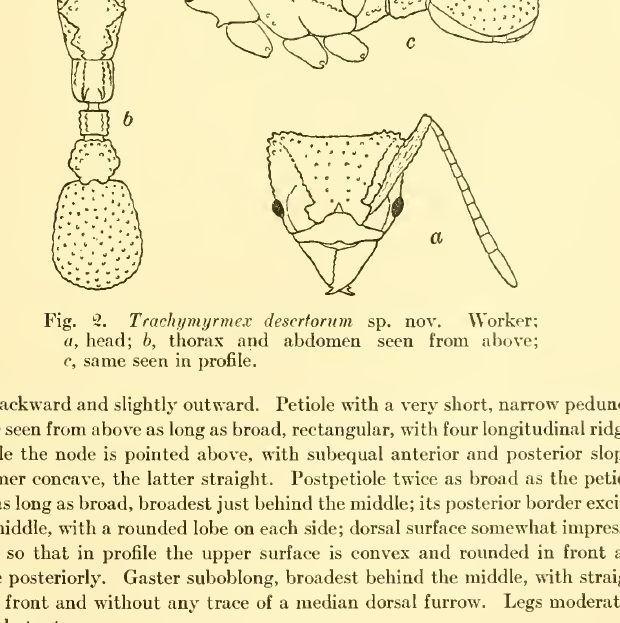
concave posteriorly. Gaster suboblong, broadest behind the middle, with straight sides in front and without any trace of a median dorsal furrow. Legs moderately long and